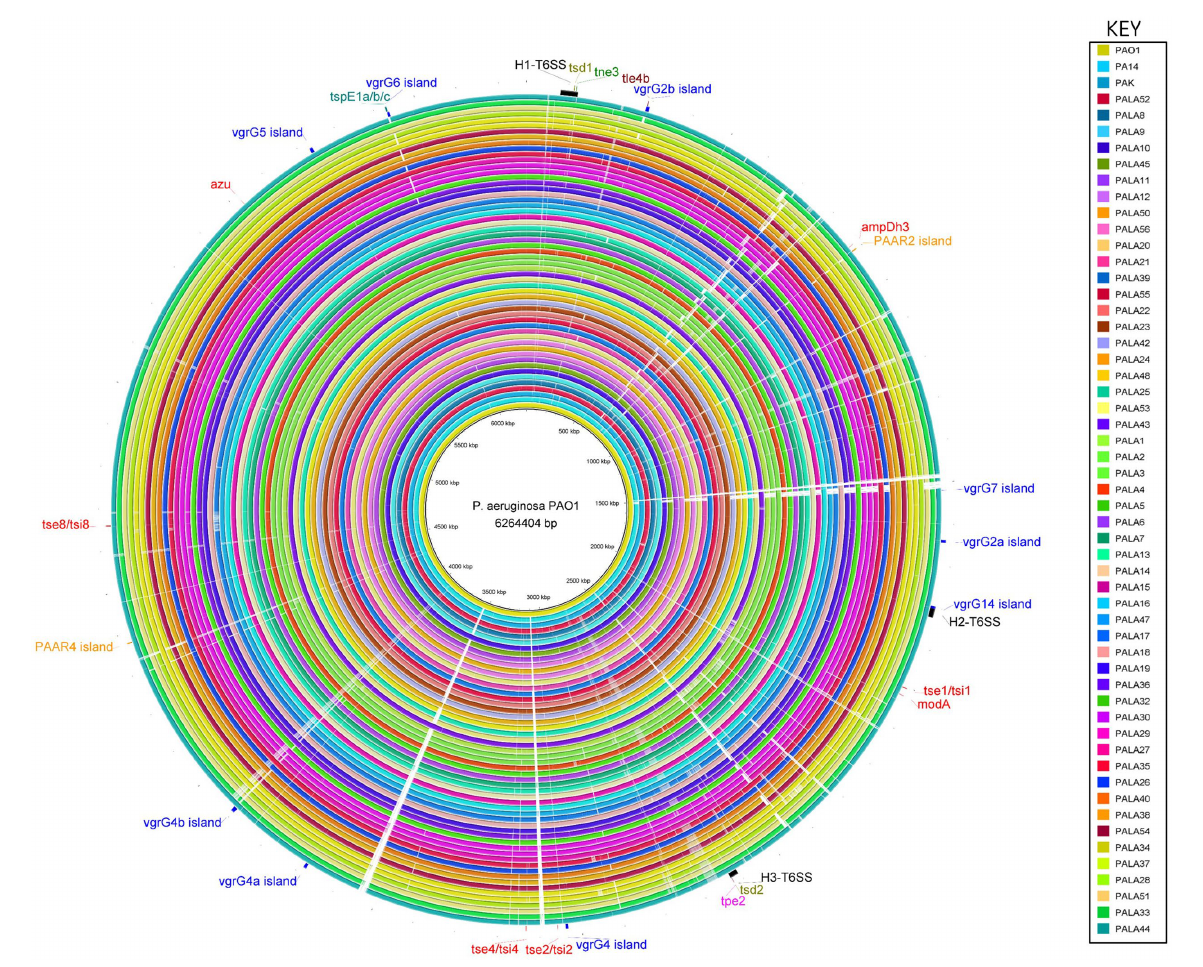
FIGURE 6 Comparative analysis of PAO1 to 52 clinical isolates under study and reference strains PA14 and PAK using the BLAST Ring Image Generator (BRIG) shows conservation of the genomes, and location, distribution and variation of T6SS genes. The innermost ring represents the genomic sequence of PAO1, followed by PA14 and then PAK. The remaining concentric rings represent the isolate sequences coloured according to the key. The intensity of the coloured ring signifies the genetic similarity of the reference sequence (PAO1) to the compared isolate (e.g., gaps = <50% similarity at the specific genomic loci). T6SS clusters, islands and effectors are labelled at the respective genomic loci in the reference strain PAO1. Central T6SS gene clusters are coloured black, vgrG islands are blue, PAAR islands are orange, and orphan effectors are red. The positions of the genes encoding the eight putative T6SS effectors described in this study are colour coded: putative cytidine deaminases ( tsd1 / tsd2 ) are olive, putative NADase ( tne3 ) are green, putative lipases ( tle4b ) are maroon, putative metallopeptidase ( tpe2 ) are pink, and putative pyocins are teal ( tspE1a / b / c ). The figure was produced using BRIG (Alikhan et al.,